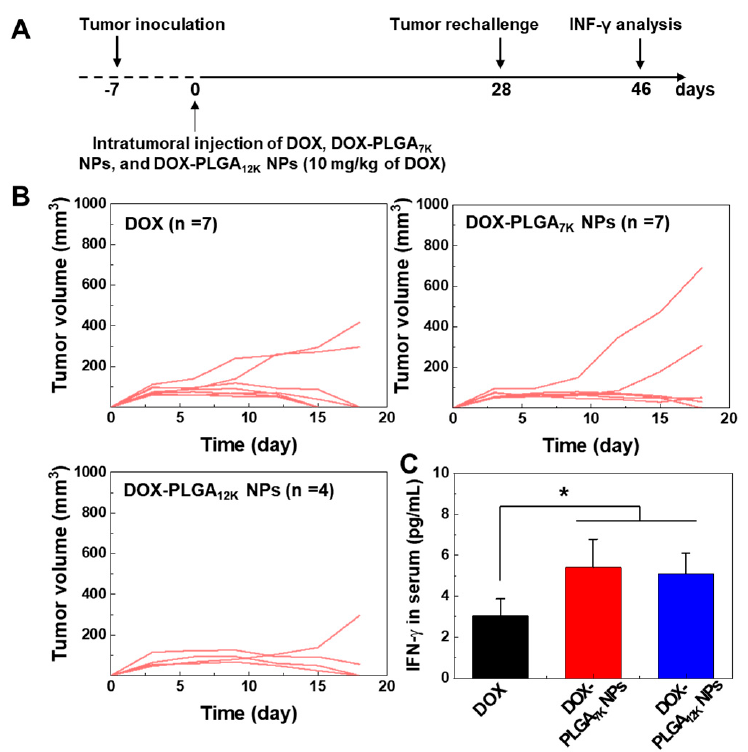
Figure 5. Immune-memory effect evaluation. ( A ) The illustration of an in vivo tumor re-challenging schedule. ( B ) Tumor growth after the CT-26 tumor cell re-challenge in the tumor-suppressed mouse, which were treated with DOX-HCl-, DOX-PLGA 7K NPs-, or DOX-PLGA 12K NPs. ( C ) Quantified amount of secreted INF- γ in the serum on Day 18 after the CT-26 tumor cell re-challenge. An asterisk (*) indicates a difference at the p < 0.05 significance level.